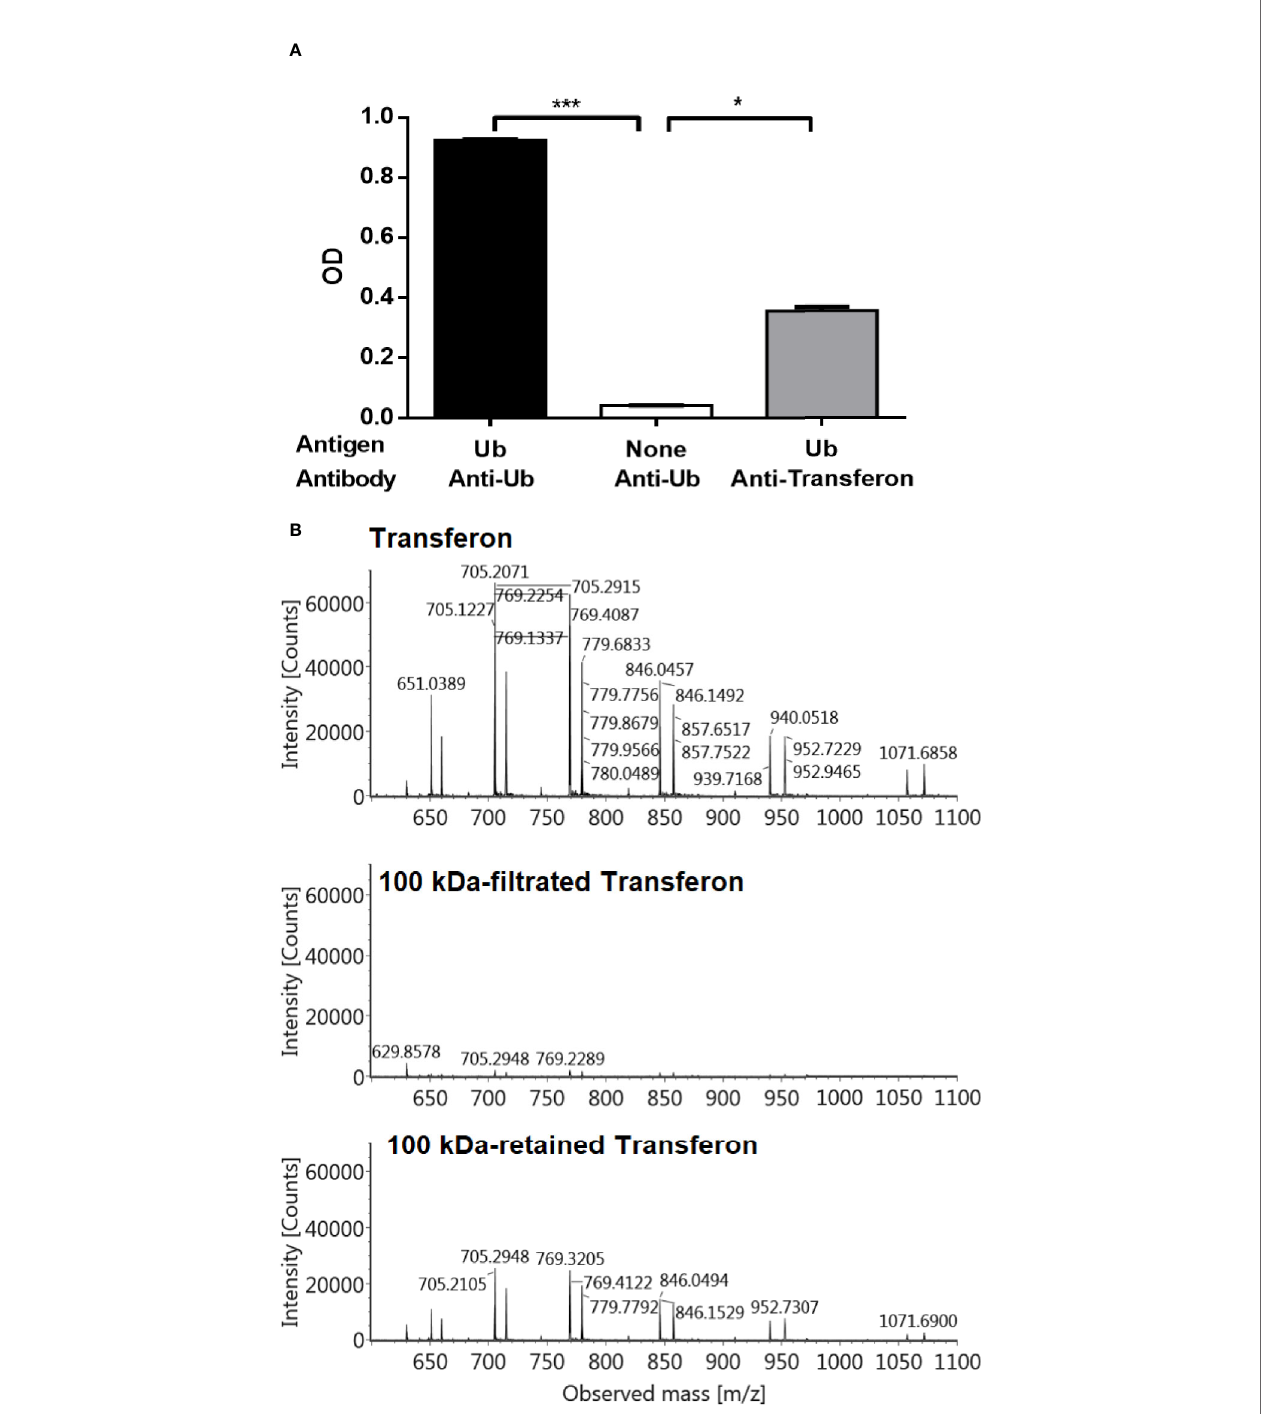
FIGURE 7 | Analysis of Ub and Ub(-GG) using polyclonal antibodies. (A) The presence of Ub in Transferon was indirectly con fi rmed using an anti-Transferon polyclonal antibody developed in rabbit by in-house methods (Mellado-Sanchez et al., 2019), which turned out to recognize monomeric Ub. The SD is presented per group. (B) Also, a 2 mg/mL of Transferon sample (Batch 19J20) was overnight incubated with a commercial anti-Ub polyclonal antibody (1:100 dilution) and fi ltrated through 100 kDa membrane. Filtrated and retained fractions were analyzed by MS. SD bars are indicated per group. OD, optical density; TMB, Tetramethylbenzidine; C, control. H = 15.6; (d f = 2, N = 18); ***P < 0.001; *P <